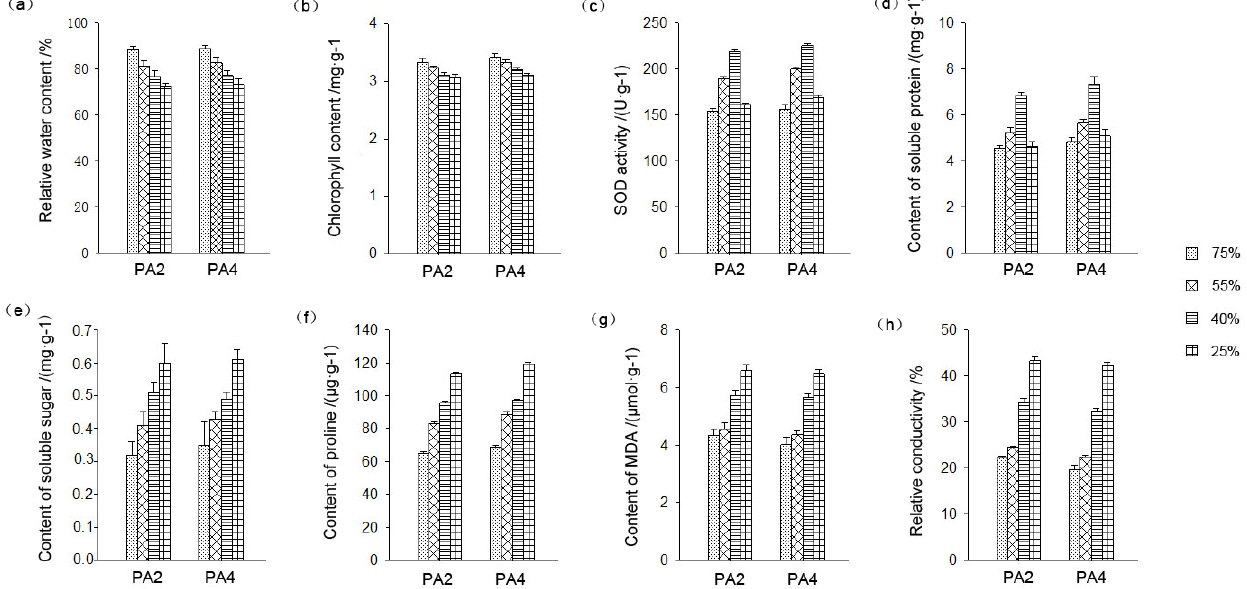
Figure 2. Effects of drought stress on P. australis physiology. PA2 represents diploid P. australis , PA4 represents autotetraploid P. australis , 75%, 55%, 40% and 25% relative soil water contents were used. ( a ) Effect of drought stress on leaf relative water content; ( b ) Effect of drought stress on leaf chlorophyll content; ( c ) Effect of drought stress on leaf superoxide dismutase (SOD) activities; ( d ) Effect of drought stress on leaf soluble protein content; ( e ) Effect of drought stress on leaf soluble sugar content; ( f ) Effect of drought stress on leaf proline content; ( g ) Effect of drought stress on leaf malondialdehyde (MDA) content; ( h ) Effect of drought stress on leaf relative conductivity